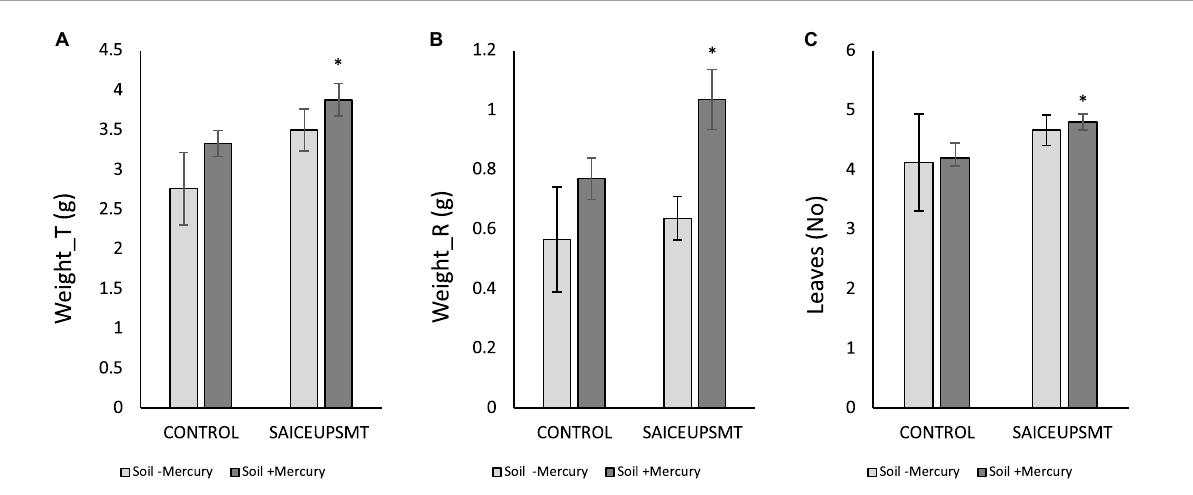
FIGURE3 Results of Kruskal–Wallis for enzymatic content: (A) catalase (CAT), (B) superoxide dismutase (SOD), (C) ascorbate peroxidase (APX), and (D) glutathione reductase (GR). The bars indicate the standard error. * p -value ≤ 0.001.